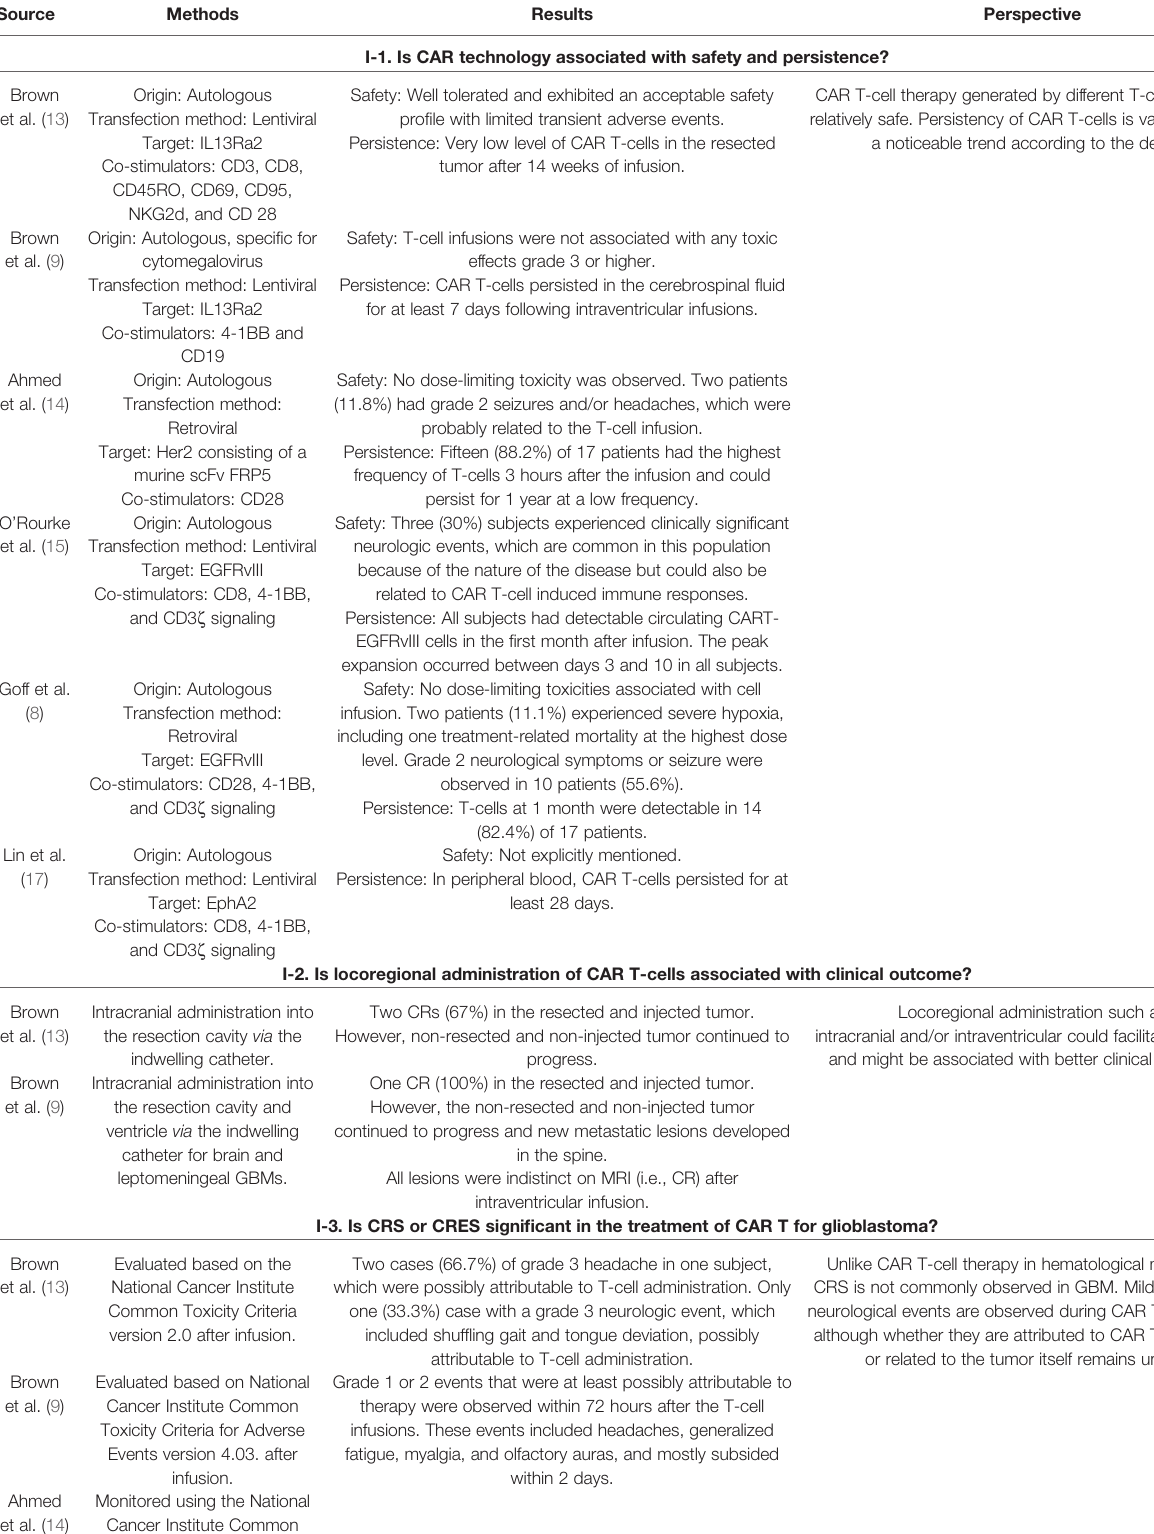
TABLE 3 | Challenging issues and current evidence from the included studies. Source Methods Results